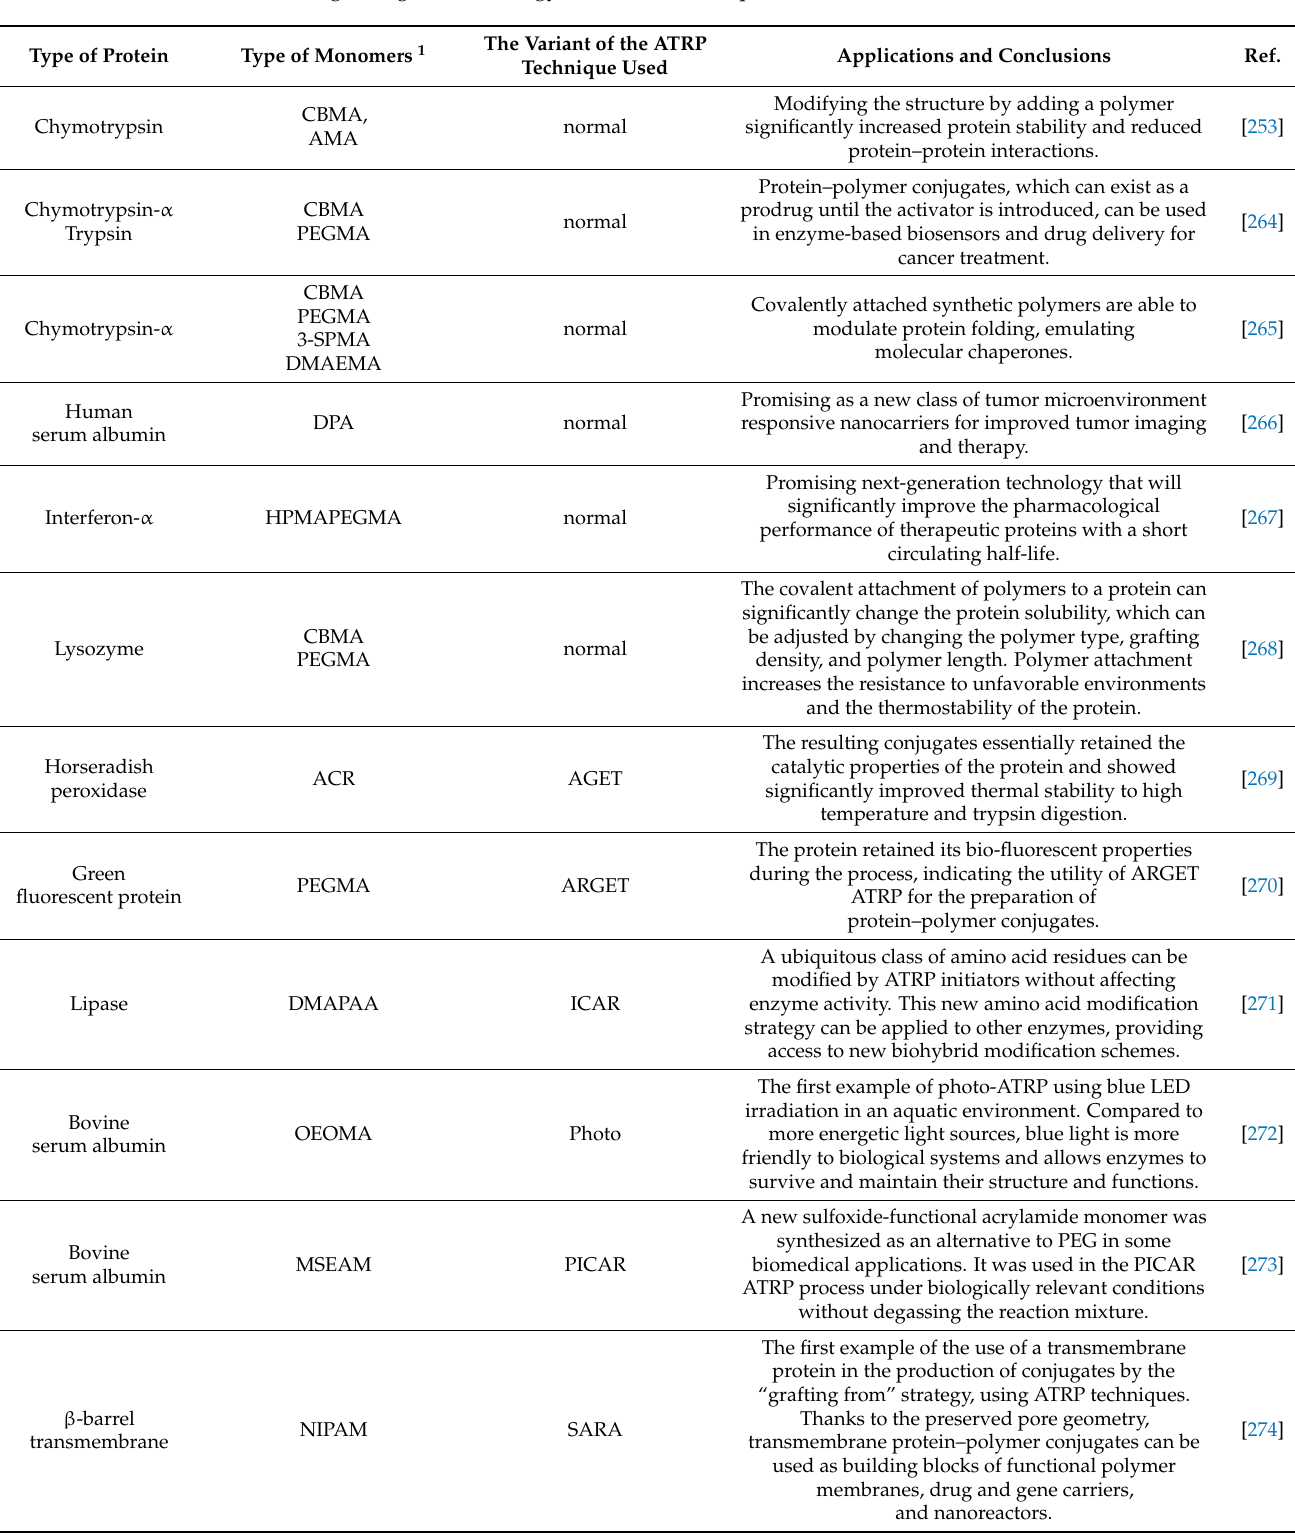
Table 4. A review of the literature on the synthesis of modern polymer–protein conjugates using the “grafting from” strategy and ATRP